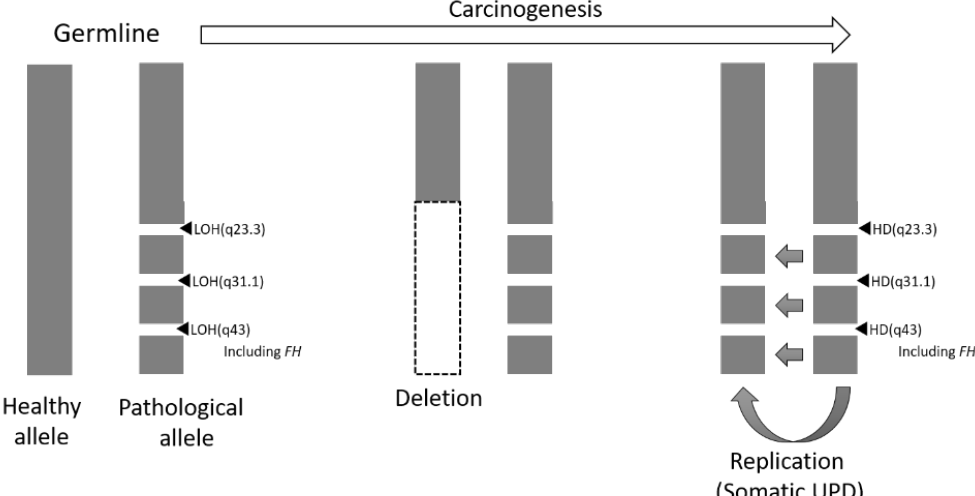
Figure 5. Schema of loss of FH expression during carcinogenesis. It is assumed that large-scale deletion and large-scale replication occurred during the process of transformation. LOH, loss of heterozygosity; UPD, acquired uniparental disomy; HD, homozygous